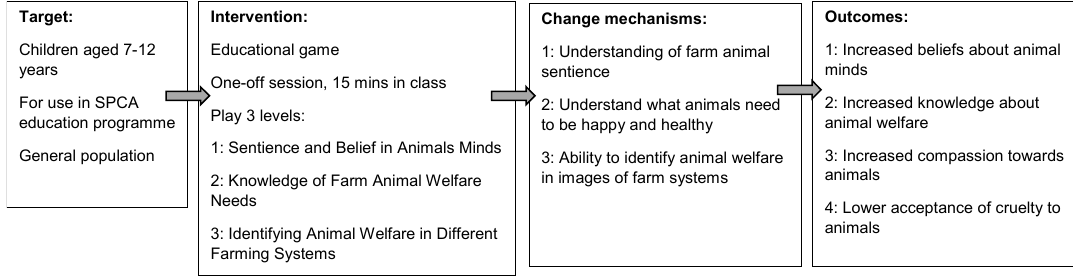
Figure 1. Logic Model for Farm Animal Welfare game.